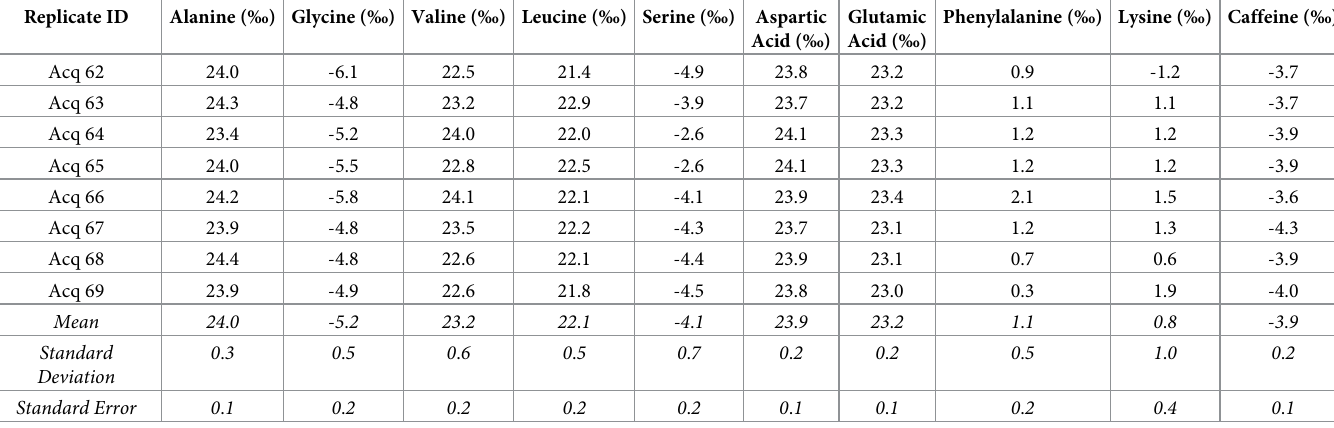
Table 2. Isotopic measurement error for nine of the 13 AAs used in the present study. Replicate